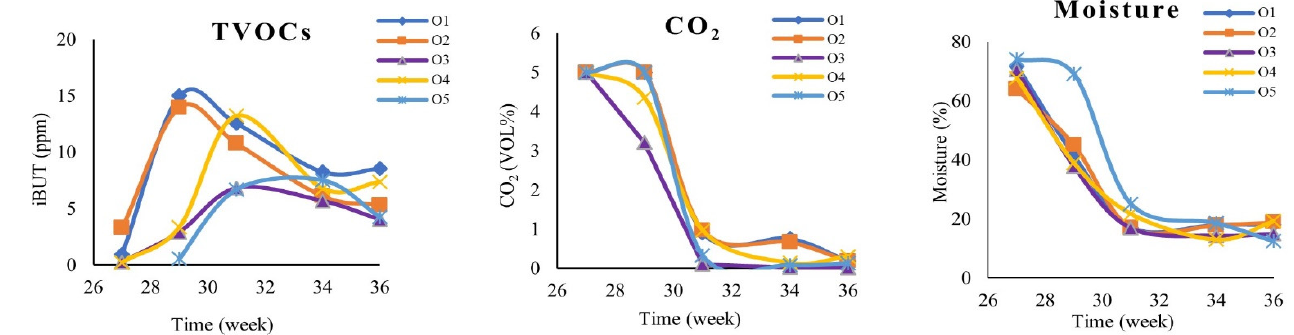
Figure 5. The trends of total VOCs (TVOCs), CO 2 and humidity per week for the orchards studied (O1, O2, O3, O4, and O5).